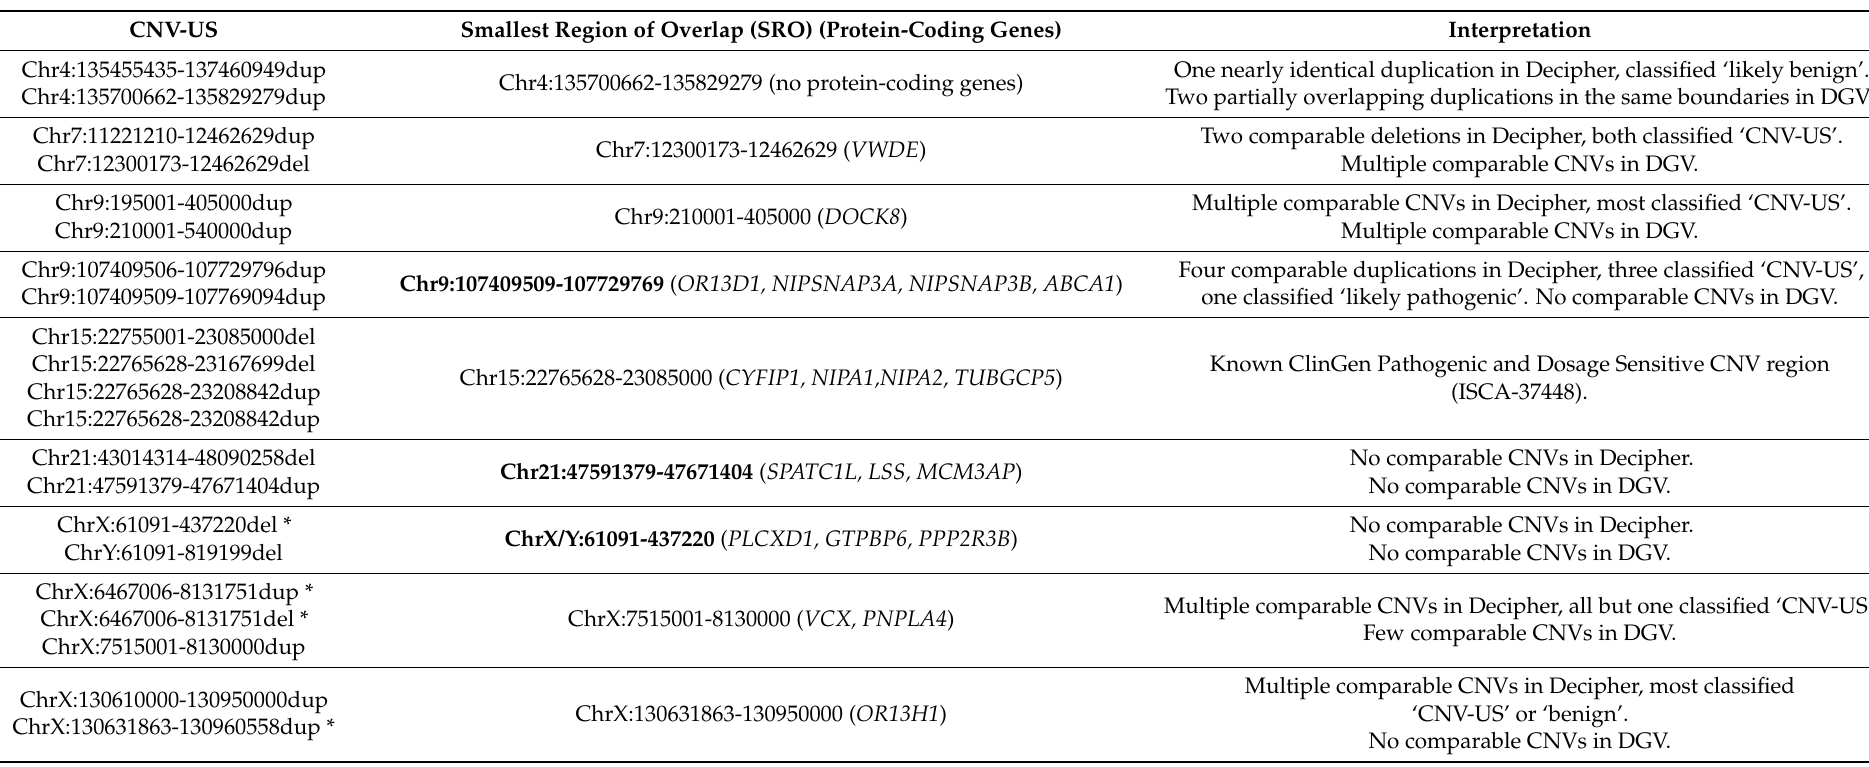
Table 2. Recurrent CNV-US regions in the study